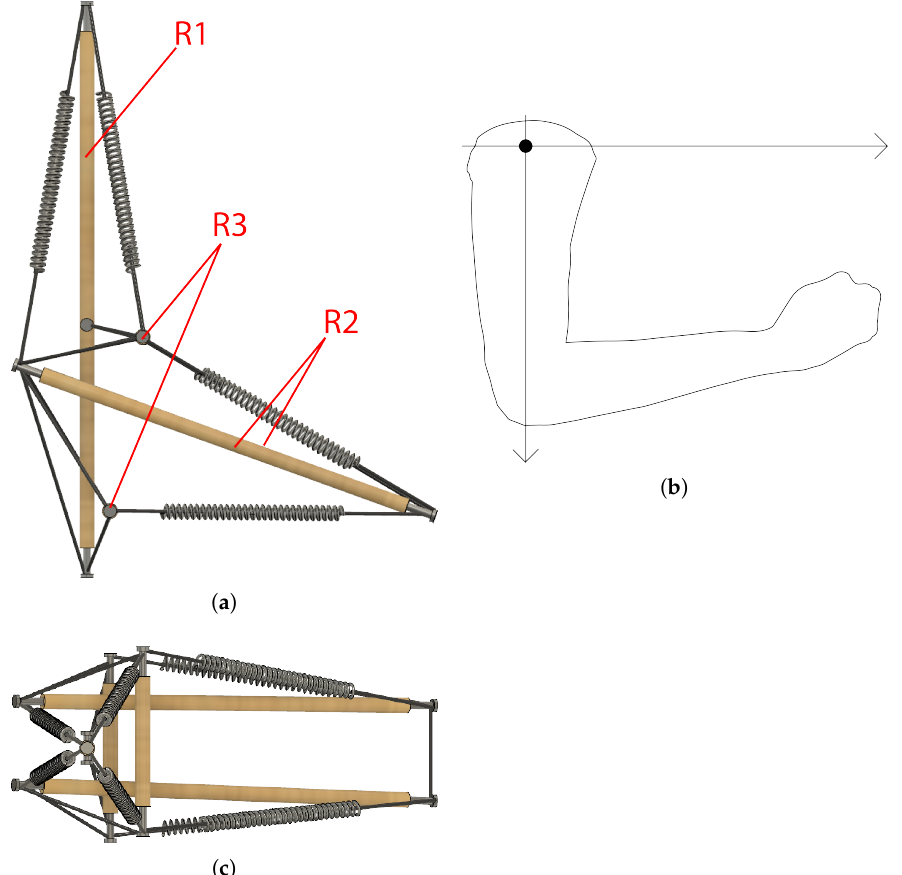
Figure 4. The correspondence between the developed tensegrity arm and a human arm. Figure ( a ) shows the model from the side and the name of each stick. Figure ( b ) shows the human arm in the orientation corresponding to Figure ( a ). Figure ( c ) shows the model from above.